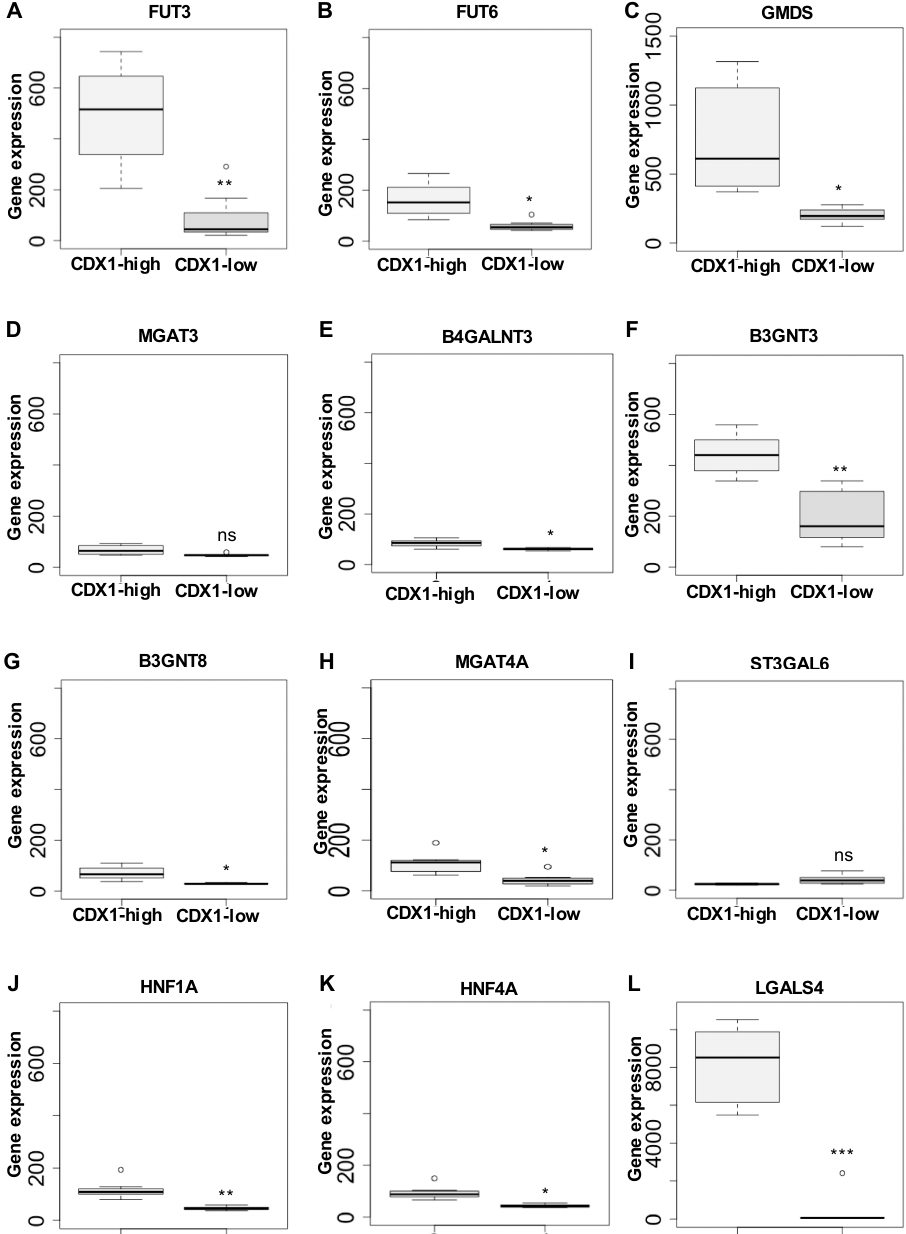
Figure 5. Differentially expressed genes related to glycosylation. N -glycomic phenotypes of the eight CDX1-high vs. eight CDX1-low cell lines were further compared to transcriptomic data of the same cell lines obtained from a gene expression microarray analysis using the Human genome U133+2 Affimetrix chips. The Y axis shows the linear normalized fluorescent intensities of the respective probesets. Differential expressions were observed for fucosyltransferase genes ( A ) FUT3 , ( B ) FUT6 , and ( C ) GMDS , for ( D ) MGAT3 (bisecting GlcNAc) and ( E ) B4GALNT3 (LacdiNAc), as well as ( F ) B3GNT3 (poly-LacNAc), ( G ) B3GNT8 (poly-LacNAc), ( H ) MGAT4A ( α 1-3-branching), and ( I ) α 2,3-sialyltransferase gene ST3GAL6. Furthermore, transcription factors ( J ) hepatocyte nuclear factor (HNF)1A, and ( K ) HNF4A, as well as ( L ) soluble galectin 4 (LGALS4) showed increased expression with high CDX1 expression in the set of 16 colorectal cancer cell lines. Differences were evaluated by a t-test . Boxplots indicate the median and interquartile range. Significances after multiple testing correction are indicated and correspond to * p -value < 0.05, ** p -value < 0.01, *** p -value < 0.001; ns